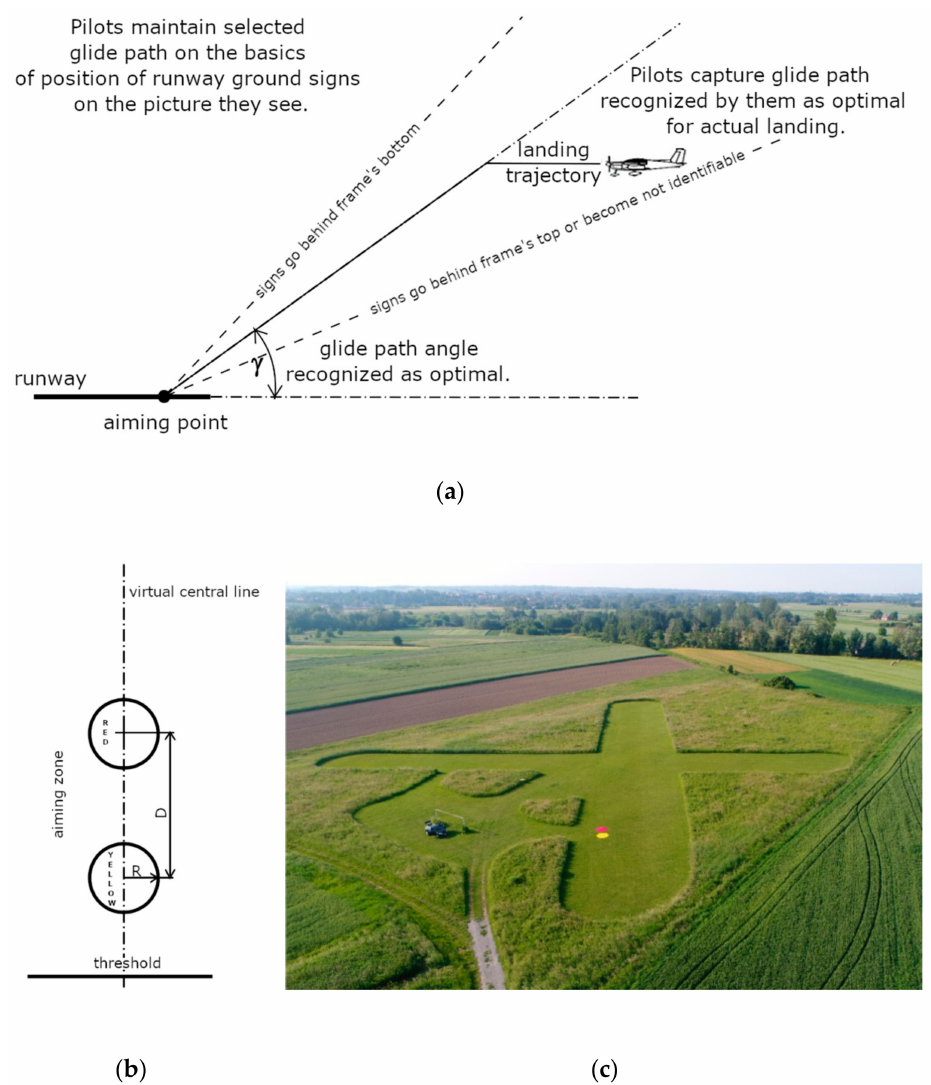
Figure 1. ( a ) General schematic of a typical VFR landing. ( b ) The schematics dedicated runway ground signs configuration. ( c ) Sample image of dedicated ground signs seen by on board